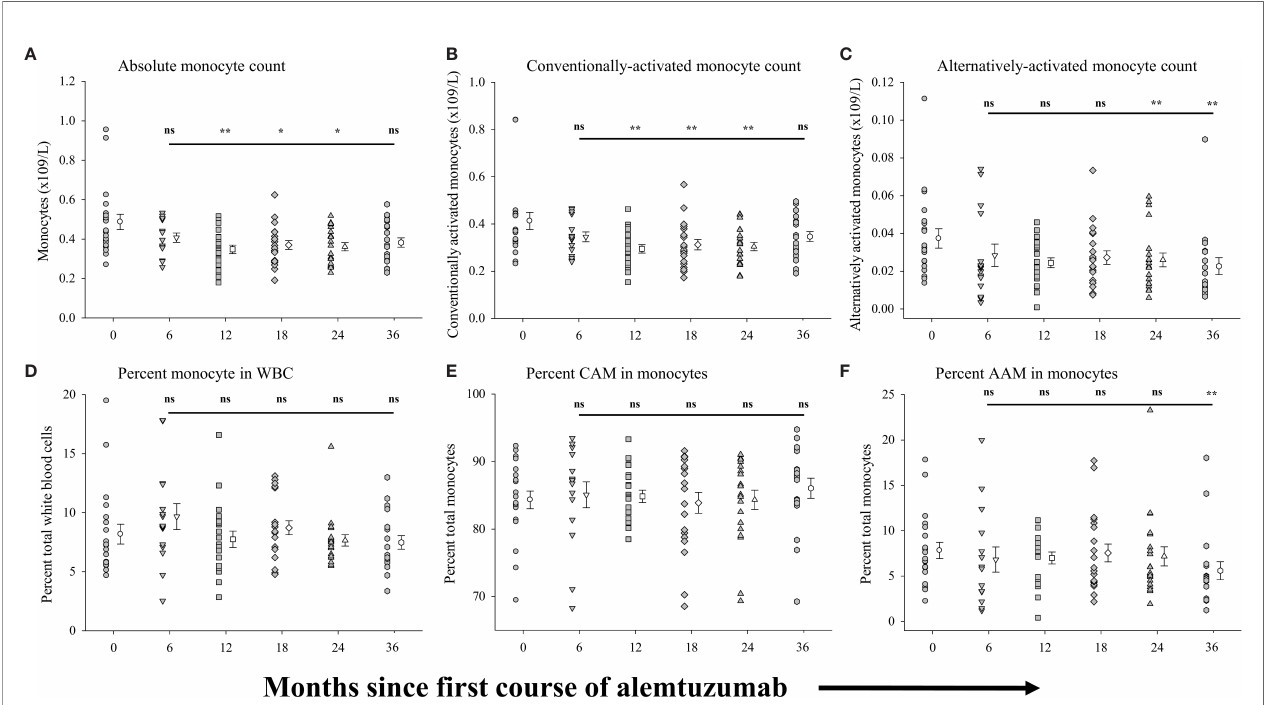
FIGURE 4 | Measures of peripheral blood monocytes following alemtuzumab treatment: Panels (A – F) illustrate different measures for each treatment cohort (6 month = inverted triangle; 12 month = square; 18 month = diamond; 24 month = triangle; 36 month = hexagon) as compared with a pre-treated patient cohort (circles). Panel (A) shows the absolute number of CD14 + monocytes per liter of blood. Panel (B) shows the absolute number of conventionally-activated monocytes (CAM; CD14 hi CD16 - ) per liter of blood. Panel (C) shows the absolute number of alternatively-activated, non-classical monocytes (AAM; CD14 low CD16 hi ) per liter of blood. Panel (D) shows the percent of CD14 + monocytes found in total white blood cells. Panel (E) shows the percent of conventionally-activated monocytes (CD14 hi CD16 - ) found within the total monocyte population. Panel (F) shows the percent of alternatively-activated, non-classical monocytes (CD14 low CD16 hi ) found within the total monocyte population. Data for each cohort in each panel shows the individual values for each patient in the cohort ( fi lled circles, fi lled triangles etc.) adjacent to the mean ( ± SEM) for the group as a whole (open circles, open triangles etc.). Signi fi cant changes compared to the pre-treated patient cohort are identi fi ed as ** (p ≤ 0.01), * (p ≤ 0.05) or ns (not signi fi cant), and are plotted above the corresponding cohort on top of the solid back